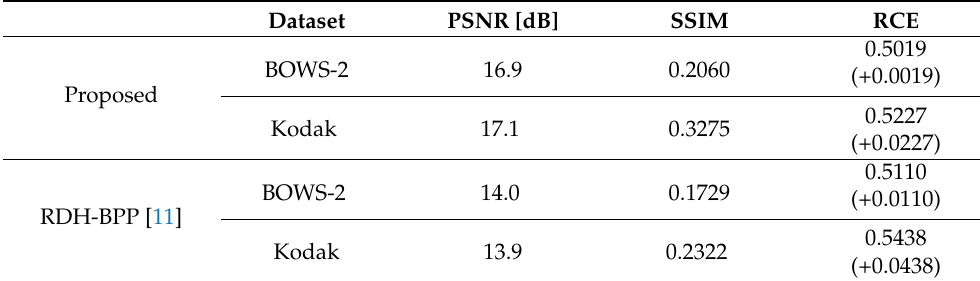
Figure 10. Marked images obtained by the proposed method (hiding capacity [bpp]/PSNR [dB]). Table 2. Marked-image quality under comparable payload